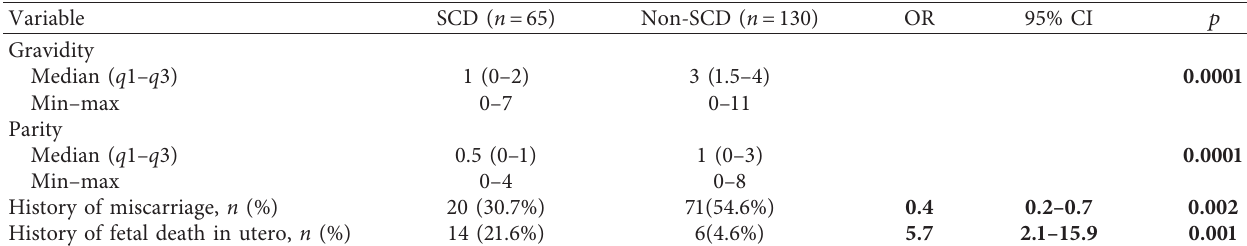
Table 1: Comparison of obstetric characteristics between women with SCD and non-SCD women seen in 4 maternity hospitals in Brazzaville between July 2017 and June 2019.